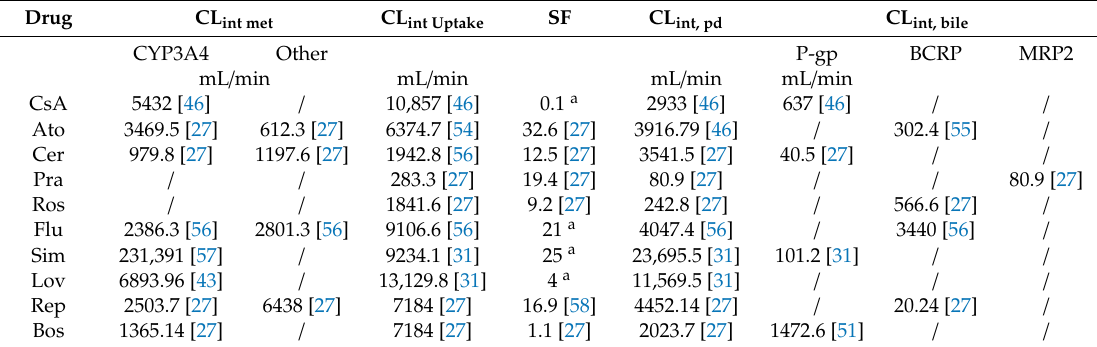
Table 3. Intrinsic metabolic / transport parameters and empirical scaling factor (SF) of cyclosporin A (CsA), atorvastatin (Ato), cerivastatin (Cer), pravastatin (Pra), rosuvastatin (Ros), fluvastatin (Flu), simvastatin (Sim), lovastatin (Lov), repaglinide (Rep) and bosentan (Bos) in the liver.